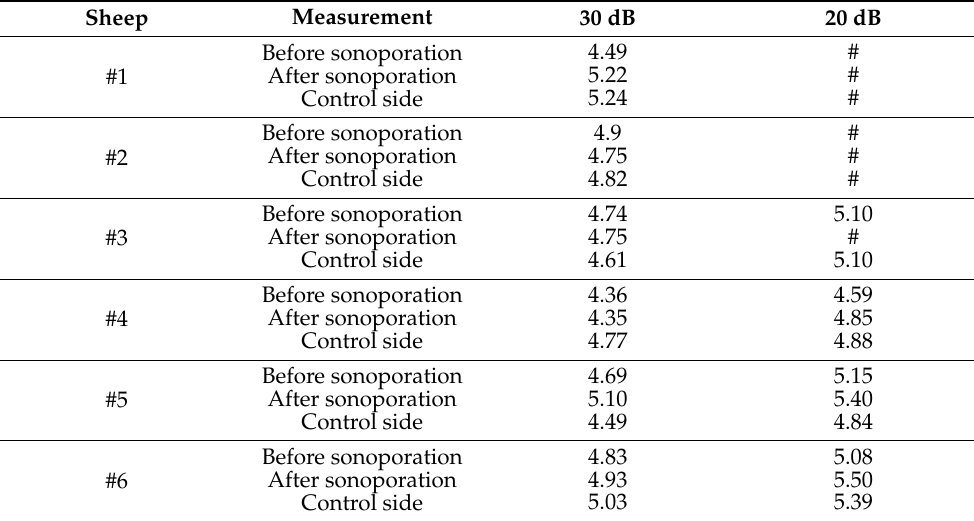
Table 2. Latency measurements for Wave IV in milliseconds (ms) at 30 and 20 dB for each sheep before and after sonoporation, and for control side. # indicates missing values.